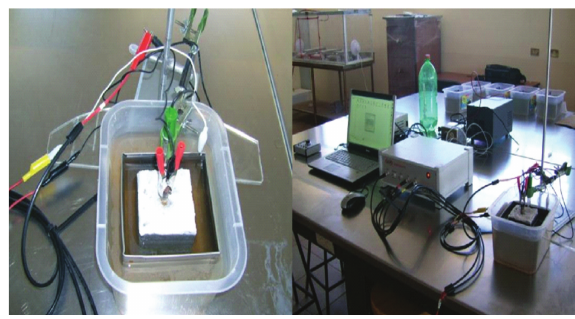
Figure 1: Experimental